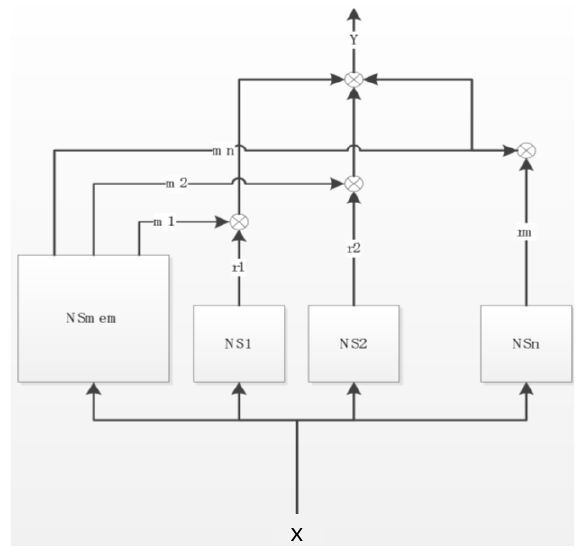
Figure 2. The conceptual scheme of a NARA neural network with neural